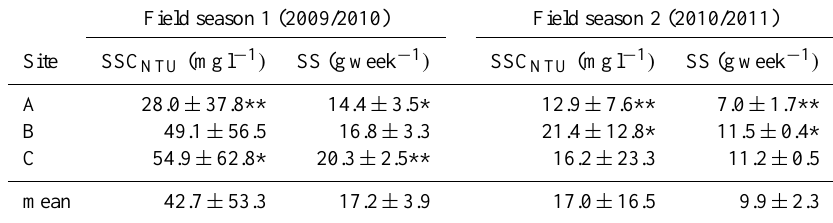
Differences between seasons are highly significant for all sites and both measurement devices (t-test, p< 0.01). * Differs significantly from the two other sites (ANOVA, p< 0.05). ** Differs highly significantly from the two other sites (ANOVA, p< 0.01).